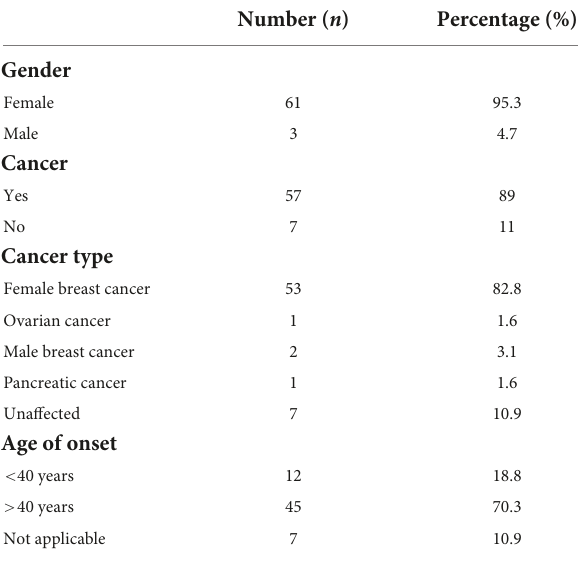
TABLE 1 Demographic summary of the study